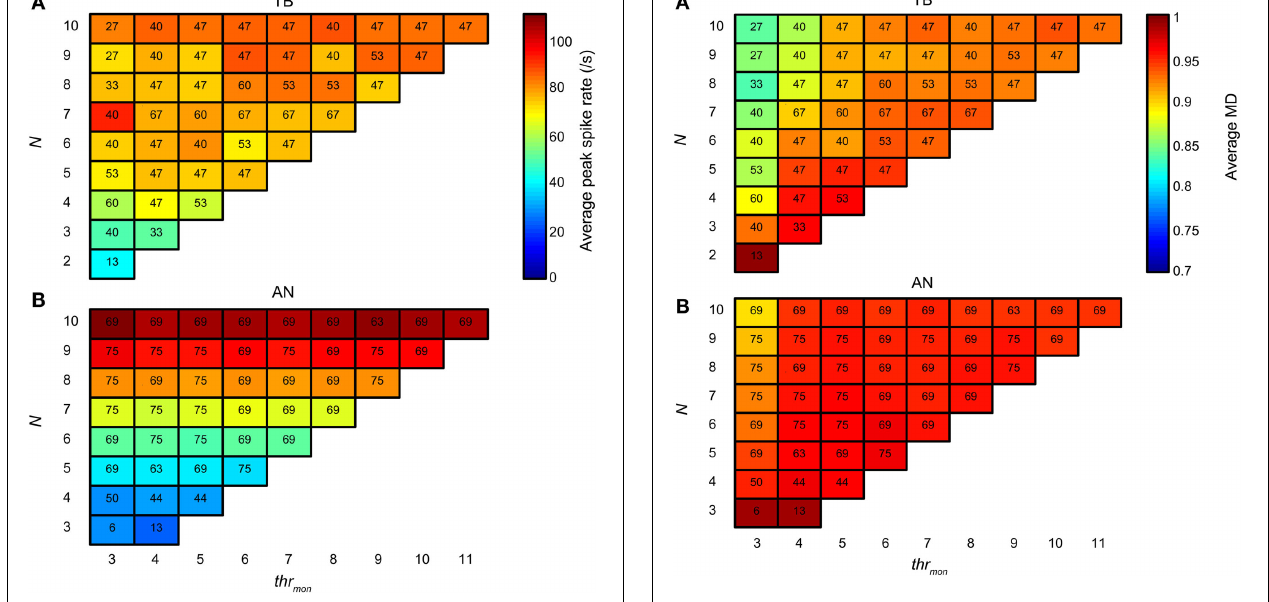
FIGURE 14 | Average spike rate at NDF peak for TB (A) and AN (B) simulations. The color of each subplot indicates the average peak rate for accepted simulations with thr mon and N indicated respectively by the abscissa and ordinate. cw = 50 μ s, and thr bin = 2. Color scale is the same in (A) and (B) . The number in each subplot indicates which proportion (in %) of the individual datasets had at least one accepted simulation for that combination of parameters.